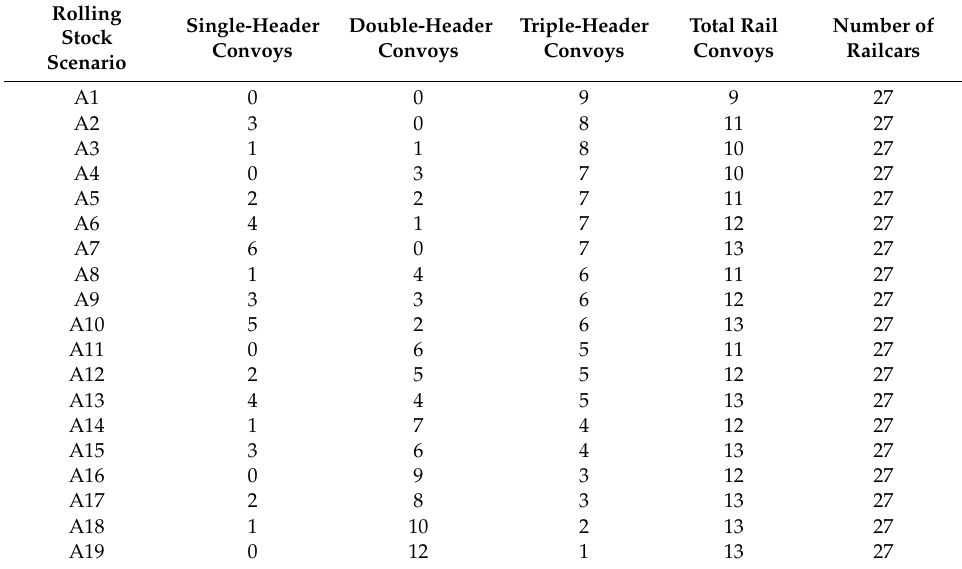
Table 2. Feasible rolling stock combinations in ordinary conditions.